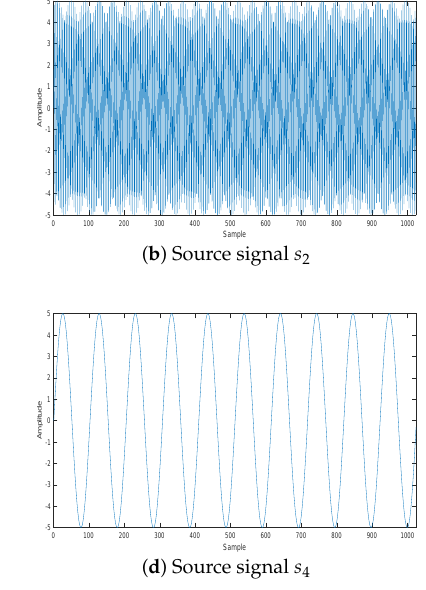
Figure 10. Source signal.